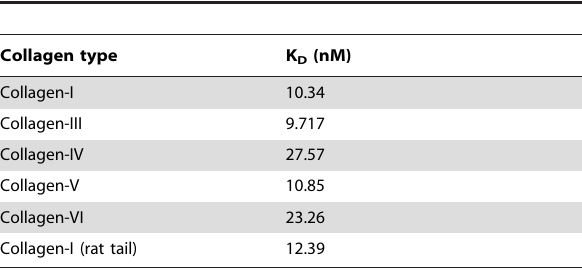
Table 2. Binding constant of Simplagrin with different types of collagen.